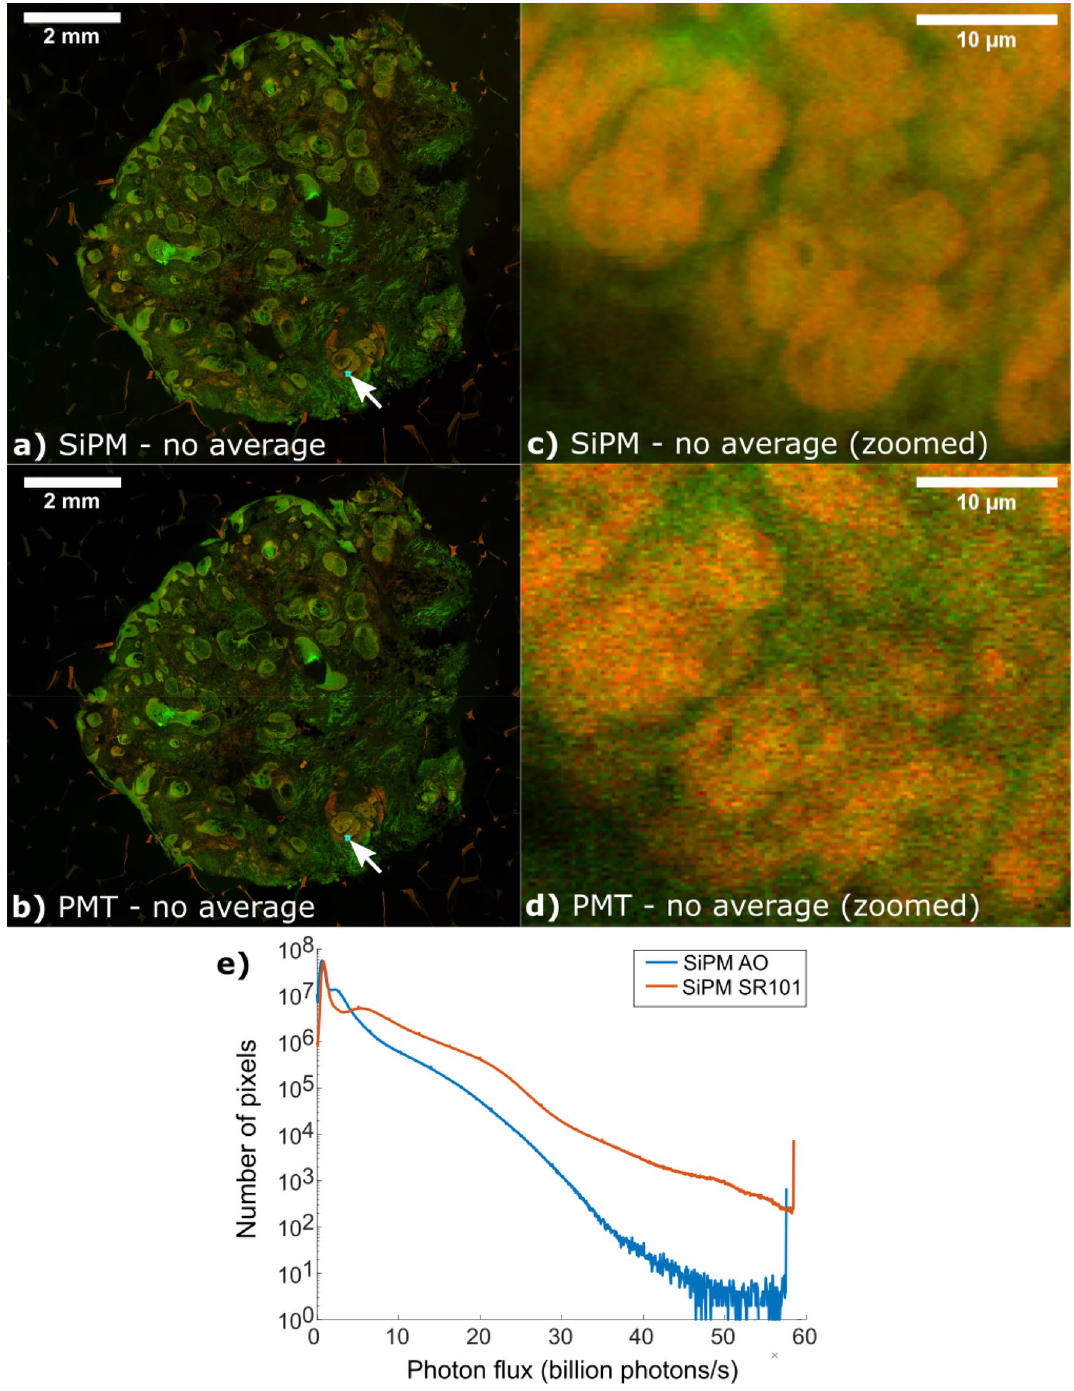
Figure 9. SiPM vs PMT tissue specimen mosaic comparison. Comparison mosaics between ( a ) SiPMs and ( b ) PMTs using an AO and SR101 labeled surgical specimen acquired at 50 MP/s. Zoomed views ( c , d ) of the blue box region show basal cell carcinoma. In contrast to the PMT, the SiPM has dramatically higher SNR due to much higher photon counts enabling visualization of sub-nuclear features in carcinoma cells ( c ) that are obscured by shot noise in ( d ). Histogram values of the per pixel photon flux for the SiPM ( e ) showing the distribution of photon detection rates in ( a ). Note that generating a similar histogram for the PMT is not possible because excess noise prevents calculation of the PTC for the PMT. Full resolution link: https ://imsto re.circ.roche ster.edu/paper s/sipm2 020/sipmV sPmtM osaic